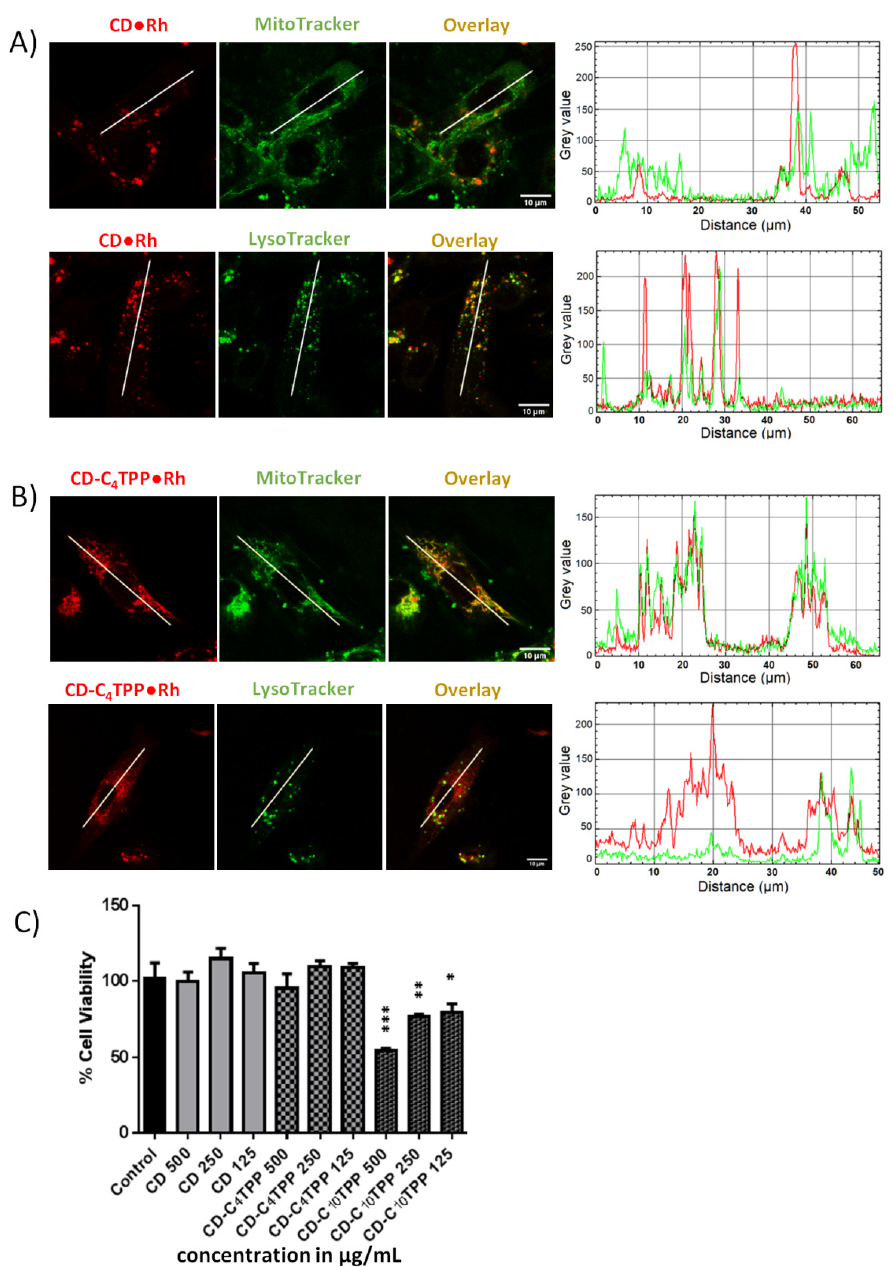
Figure 3. CD•Rh and CD-C4TPP•Rh internalization in live MDA-MB-231 cells. ( A , B ) Cells